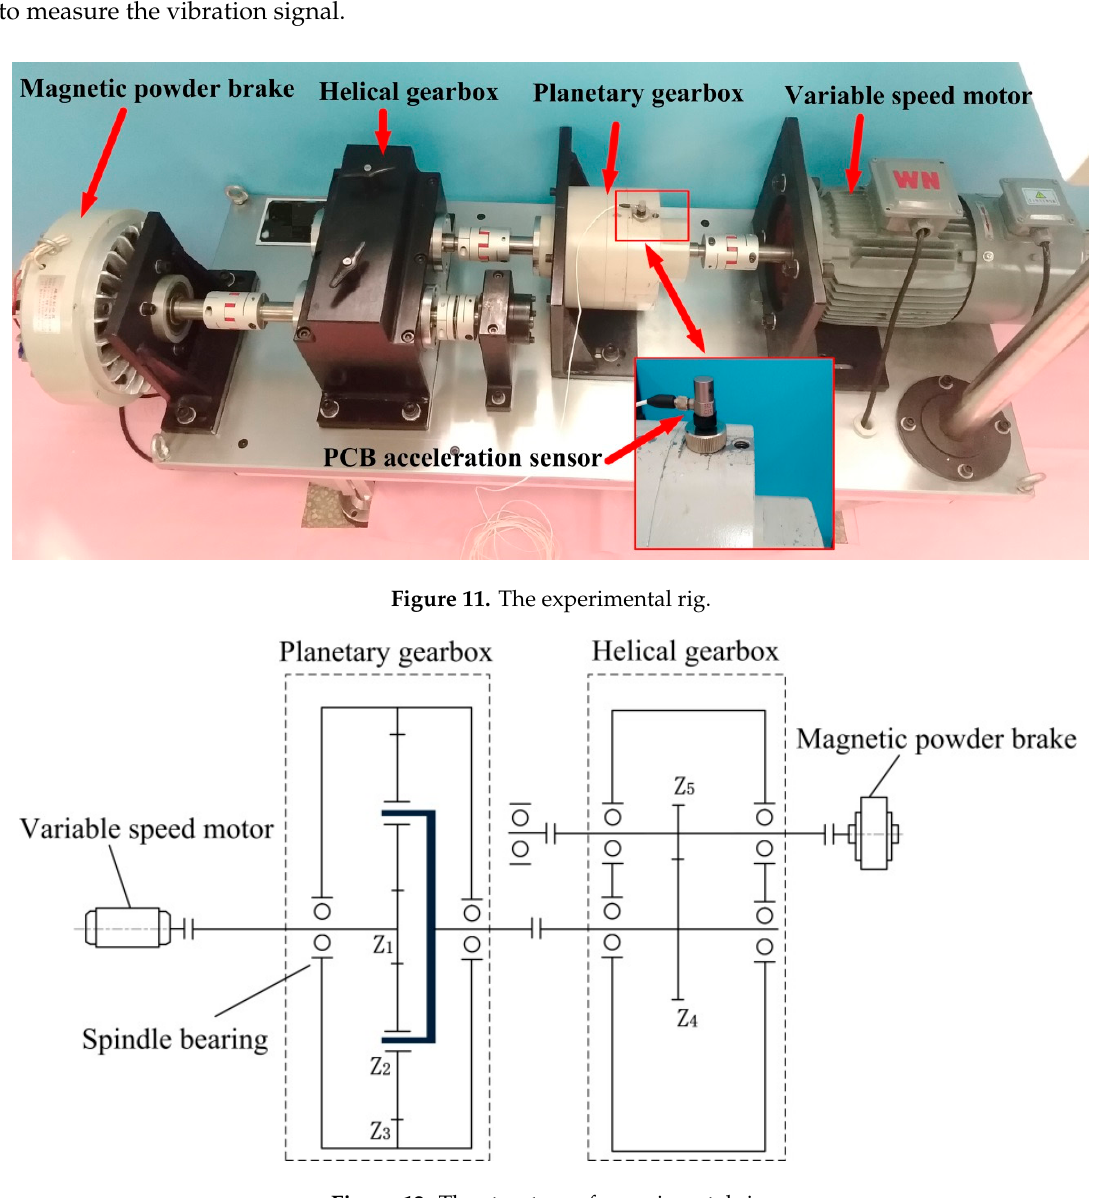
Figure 13. The damage of the sun gear.